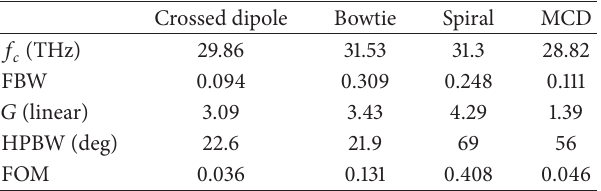
Table 1: Performance comparison of antennas.